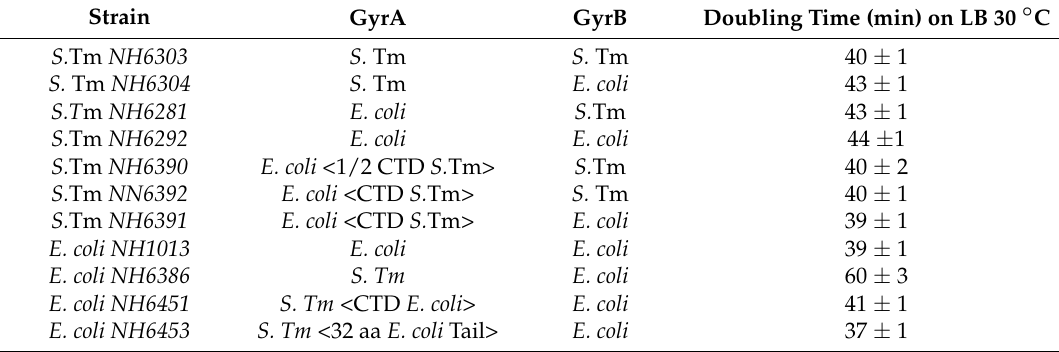
Table 1. Doubling times of S. Typhimurium and E. coli strains with different gyrase subunits and chimeric gyrases containing GyrA fusions to whole CTD or 1/2 CDT domains of Salmonella gyrA